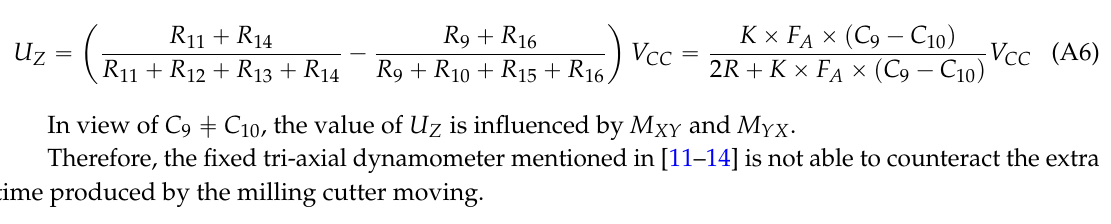
Figure A3. ( a ) Ring B and C under Z axial moment; ( b ) Ring A and D under Z axial moment. Based on Equation (A5), the output voltage of U Z is given in Equation (A6):